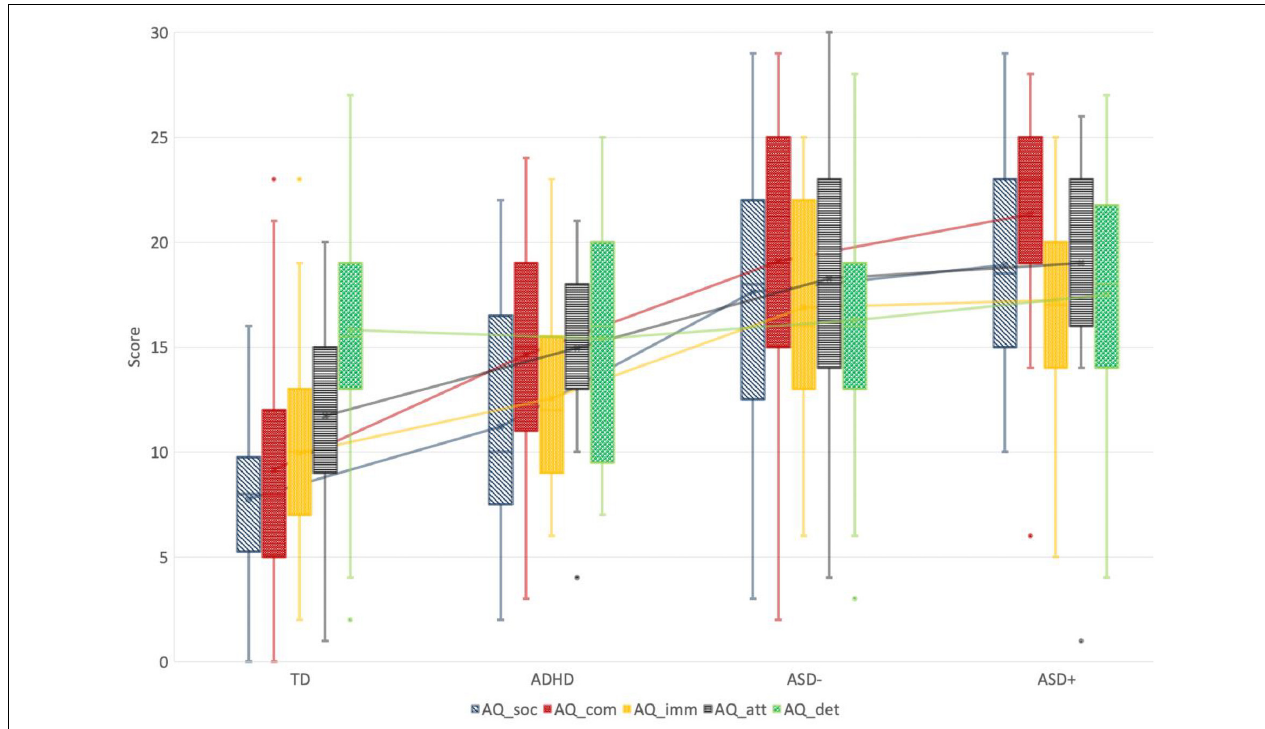
FIGURE 2 | Group differences on the C-AQ subscales scores. TD, Typical Development Group; ADHD, Attention Deficit and Hyperactivity Group; ASD–, Autism Spectrum Disorder Group; ASD+, ASD with comorbid ADHD group; AAQ_soc, Autism Quotient Children—Social Skills Subscale; AQ_com, Autism Quotient